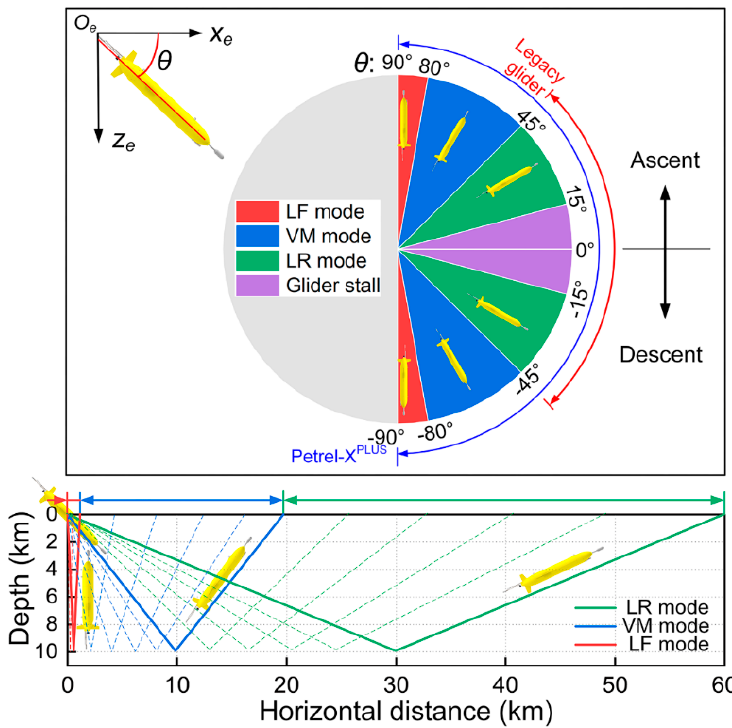
Figure 3. Schematic diagram of the division of the three typical motion modes.